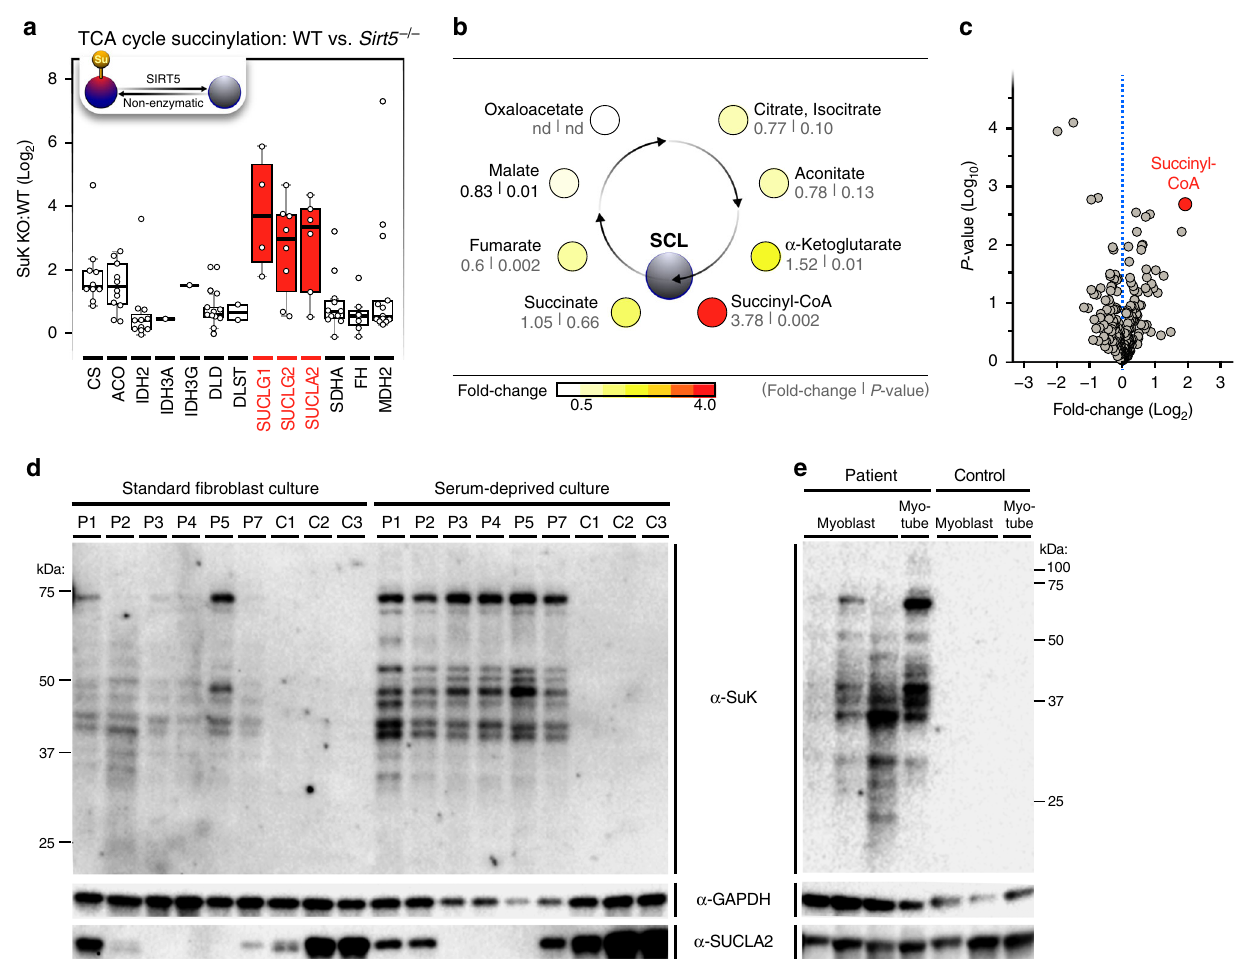
Fig. 1 SCL de fi ciency causes global protein hyper-succinylation. a Quantitation of murine liver proteome succinylation shows TCA cycle enzymes are targets of lysine succinylation in mice (C57/BL6, n = 10 wild-type, n = 10 Sirt5 − / − ). The SCL complex shows higher fold-changes than other TCA cycle enzymes. “ Su ” in the scheme indicates a succinylation modi fi cation that is removed by SIRT5. The boxplot shows the median, the fi rst to third quartile, the 1.5x interquartile ranges, and outliers. b Untargeted metabolomics show more succinyl-CoA and α -ketoglutarate in patient-derived fi broblasts than in control fi broblasts. The color scale indicates fold-change. c Volcano plot of metabolite changes in fi broblasts from SCL patients and control fi broblasts. The red dot shows succinyl-CoA. d SDS-PAGE and western blot analysis of lysine succinylation in fi broblasts cultured in standard culture conditions (proliferative condition) and cells cultured for 5 days in low-serum conditions (non-proliferative condition). Patients (P1 – P7) carry disease-causing mutations in SUCLA2 . Controls (C1 – C3) are fi broblasts from age-matched patients with other mitochondrial diseases. e SDS-PAGE and western blot analysis of lysine succinylation during myoblast differentiation in myotubes (arrow indicates stages of differentiation) of patient with SCL de fi ciency due to Asp333Gly mutation in SUCLA2 . Control is an age-matched patient with a non-mitochondrial disease. GAPDH was used as a loading control, and residual SUCLA2 levels in patient samples are shown. Western blot images are representative results from 10 different independent experiments with similar results. The p -values were calculated with Welch two-sample t-test assuming unequal variance. Source data are provided as a Source Data fi le. WT = wild- type; SuK = succinyl-lysine, nd = not